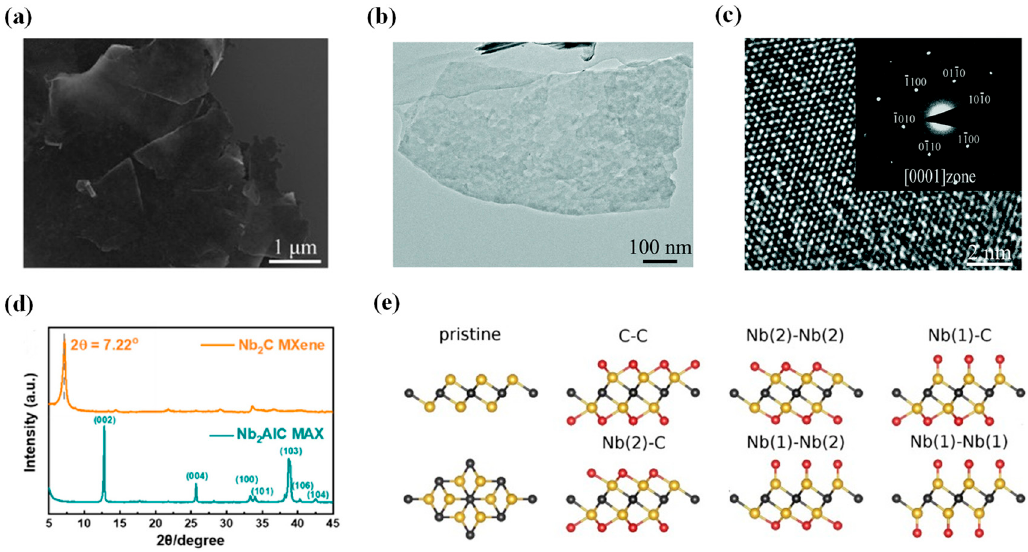
Figure 4. Characterization and structure of Nb 2 CT x . ( a ) SEM image of Nb 2 CT x , ( b ) TEM image of Nb 2 CT x , ( c ) HRTEM image of Nb 2 CT x . Reprinted with permission. [46] Copyright Royal Society of Chemistry, 2019. ( d ) XRD image of Nb 2 CT x . Reprinted with permission. [57] Copyright American Chemical Society, 2022. ( e ) Structure of Nb 2 C and Nb 2 CX 2 [68]. Copyright John Wiley & Sons, Inc.,